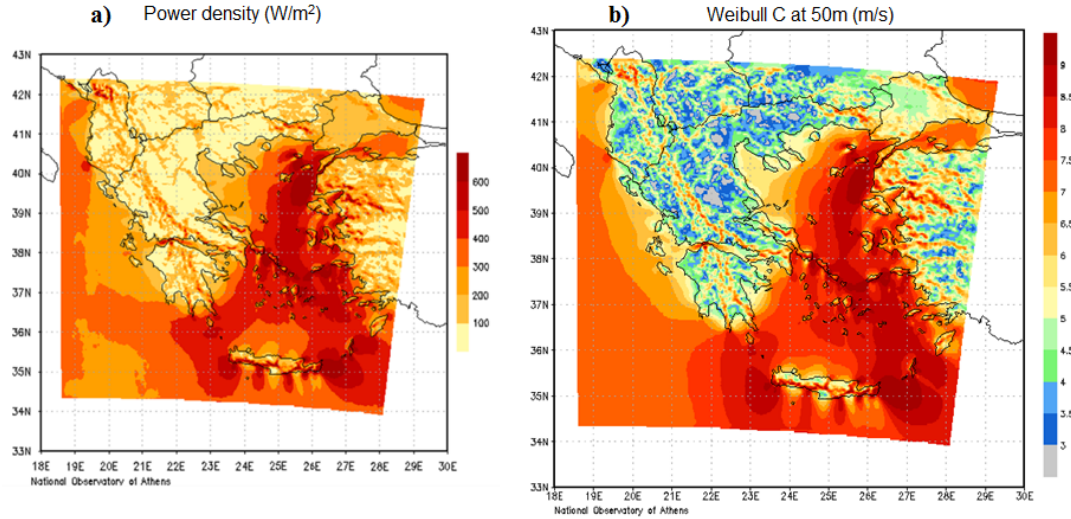
Figure 2. High resolution wind atlas for a typical wind year [38]: ( a ) power density (W/m 2 ), ( b ) parameter c (m/s) of Weibull distribution.